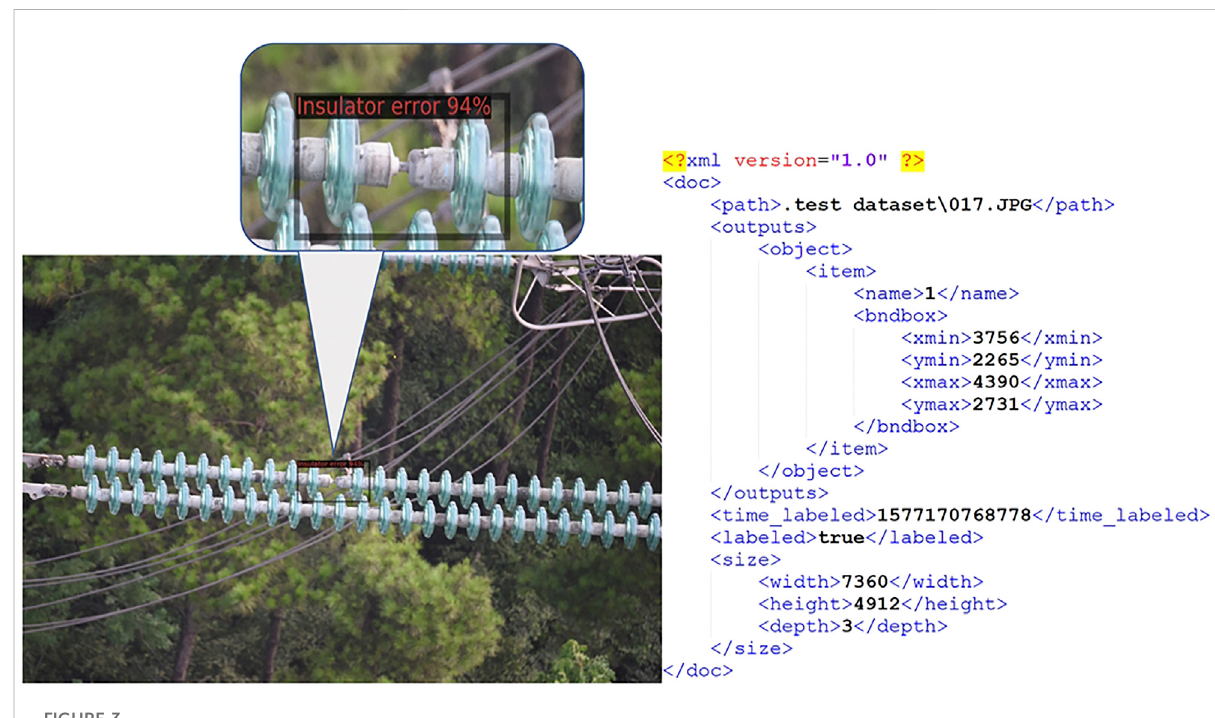
FIGURE 3 Insulator defect point detection and